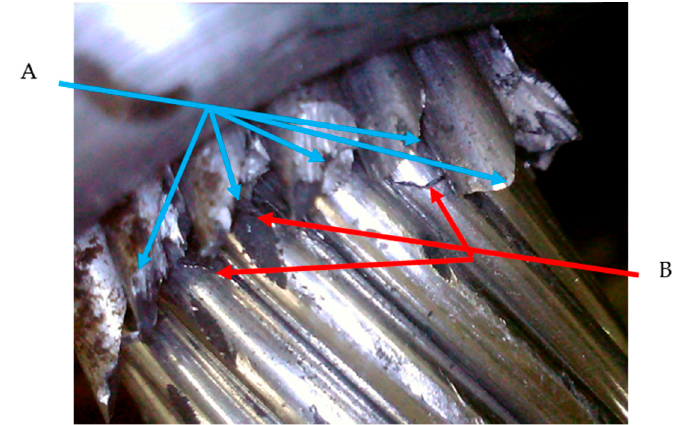
Figure 9. Fracture diagram of the third layer of conductor.